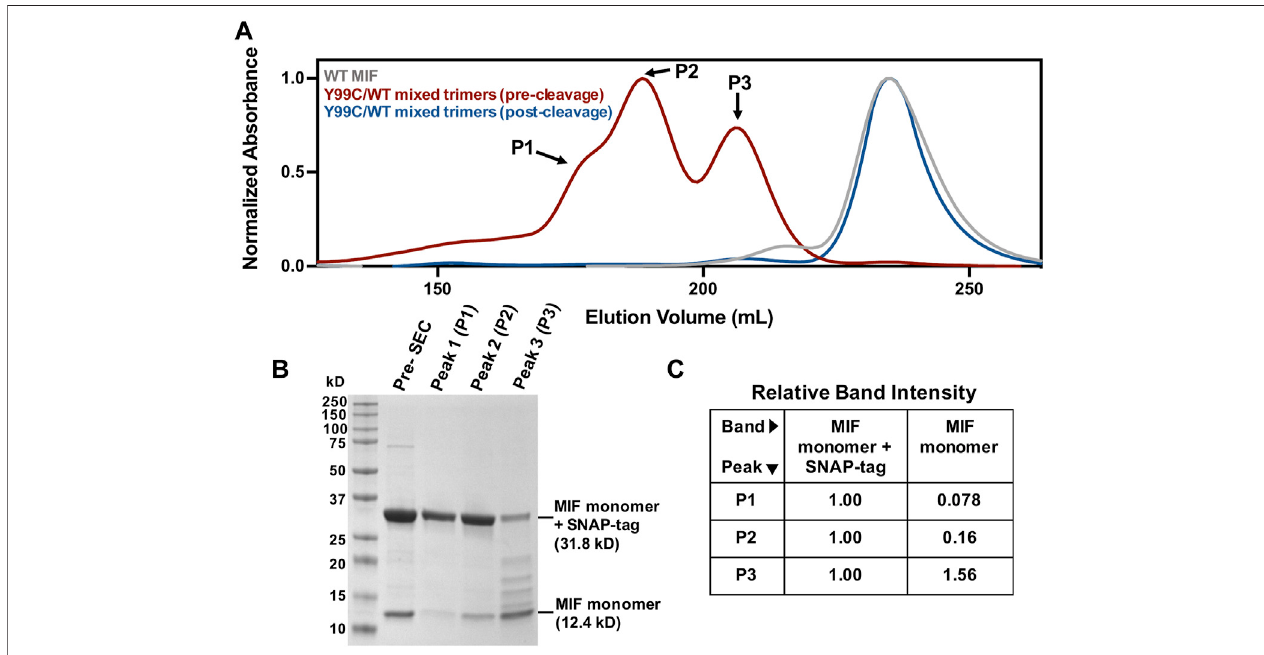
FIGURE 2 | Veri fi cation of novel Y99C/WT mixed trimers (A) Chromatographic overlay of WT MIF and the Y99C/WT mixed trimers pre- and post-tag cleavage as puri fi ed by size exclusion chromatography (SEC) (B) SDS-PAGE analysis of the Y99C/WT mixed trimer species showing the presence of the MIF monomer (12.4 kDa) and the MIF monomer + SNAP-tag (31.8 kD) in peaks 1-3 (C) Relative SDS-PAGE band intensities of the MIF monomer and the MIF monomer + SNAP-tag bands from (B) via ImageJ software (NIH). Each lane was analyzed separately and normalized such that the MIF monomer + SNAP-tag band is equal to